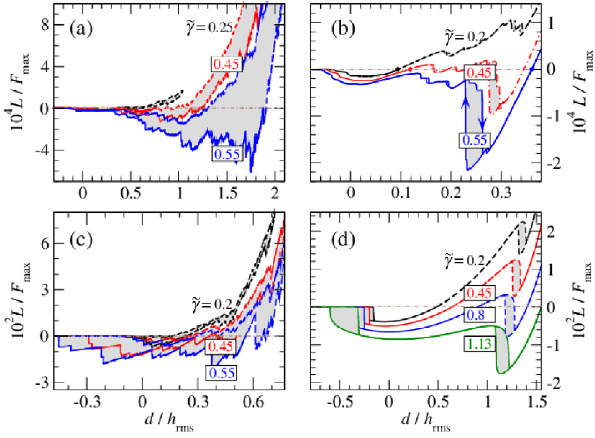
Fig. 7 Reduced compressive force, or, load of the dimensionless interference retraction for different reduced surface energies γ  and different indenters. Their dimensionless numbers other than 0.8  H are